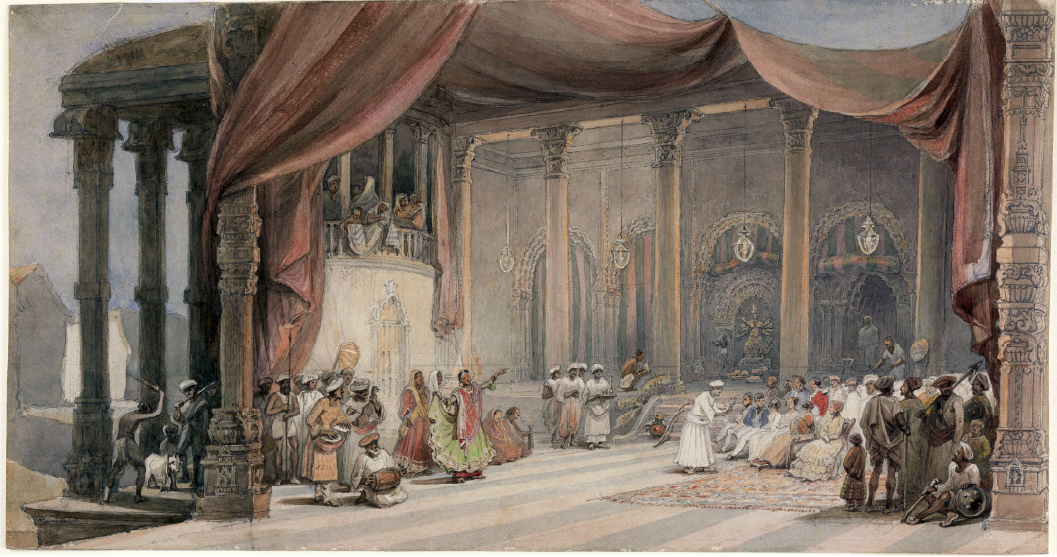
Figure 10. William Prinsep, Europeans being Entertained by Dancers and Musicians in a Splendid Indian House in Calcutta during Durga Puja